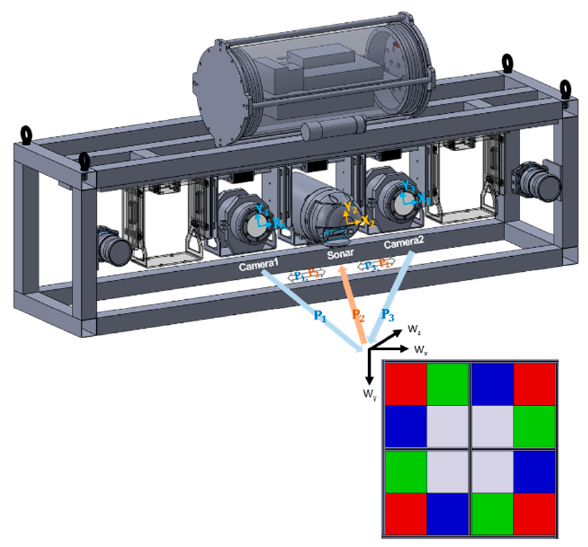
Figure 7. World coordinates ( W x , W y , W z ), optical, and sonar image coordinates ( X n , Y n ; n = 1 , 2 , 3 ).